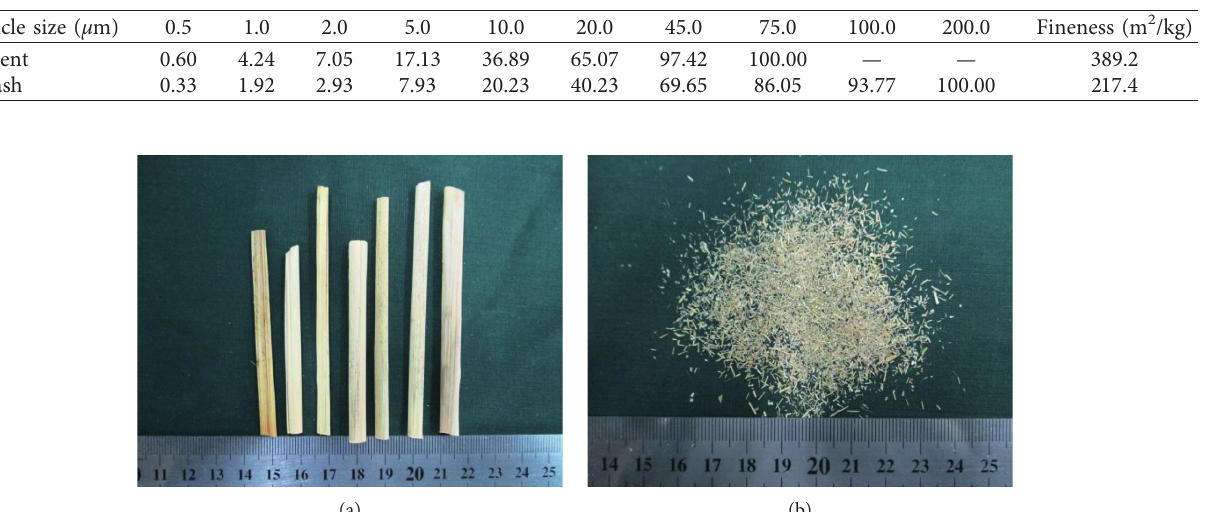
Table 2: Particle size distribution and fineness of cement and mineral admixtures (cumulative fraction, %).